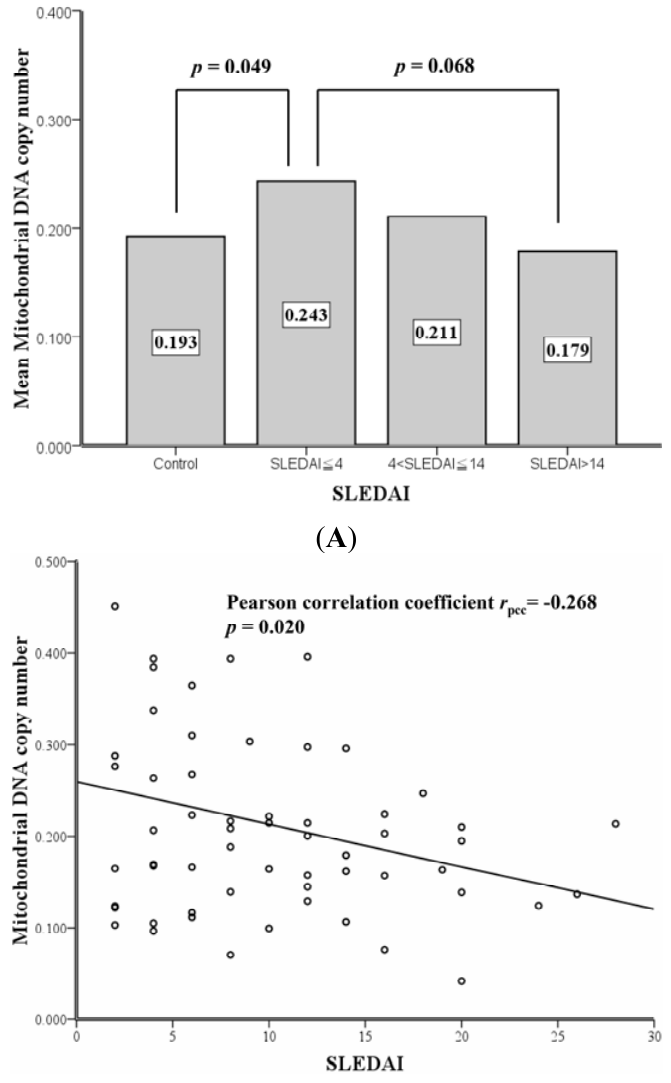
Figure 2. ( A ) The distribution of mean mtDNA copy number in the leukocytes of normal controls and SLE patients with low, medium and high SLE Disease Activity Index (DAI) scores. The mean mtDNA copy number in the leukocytes of the group with low SLEDAI score (0.243 ± 0.147) was higher than that of controls (0.193 ± 0.065) ( p = 0.049) and the group with a high SLEDAI score (0.179 ± 0.077, p = 0.068); ( B ) In SLE patients ( n = 59) with D310 heteroplasmy in mtDNA of the leukocytes, we found a negative correlation between the mtDNA copy number and SLEDAI score ( p = 0.020, Pearson’s correlation coefficient γ = − 0.268); ( C ) Among the 44 analyzed SLE patients, a positive correlation pcc was found between mtDNA copy numbers and the mRNA expression levels of mtDNA-encoded ND1 gene; ( D ) Among the 44 analyzed SLE patients, a positive correlation was found between mtDNA copy numbers and the mRNA expression levels of mtDNA-encoded ATPase 6